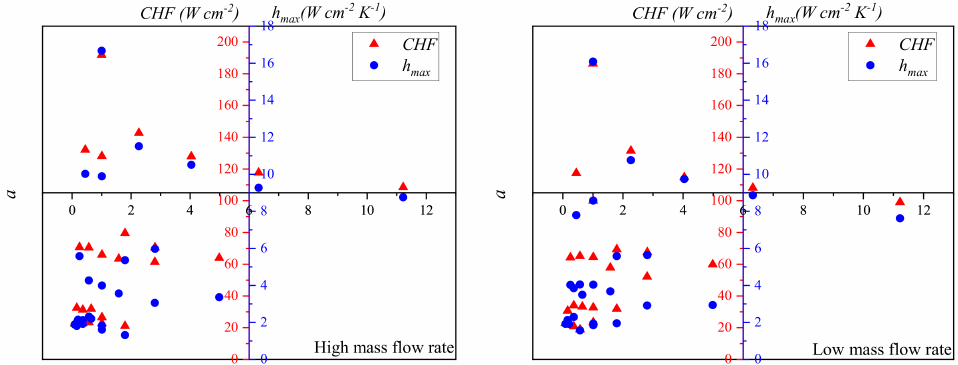
Figure 12. The distributions of CHF and h max at different mass flow rates and area ratios ( A s / A h